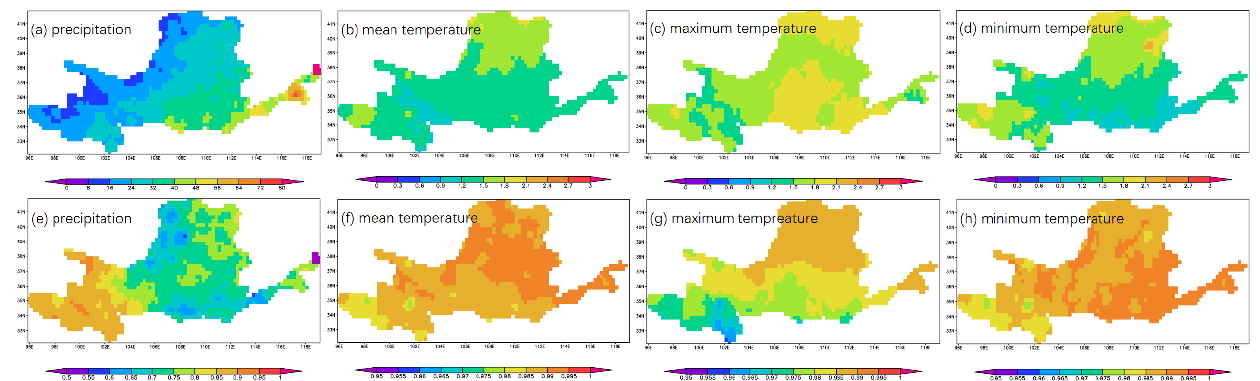
Figure 3. Spatial distribution of RMSE (a–d) and CC (e–h) showing comparison of monthly model set range simulations over the region with observations (1961–2005).